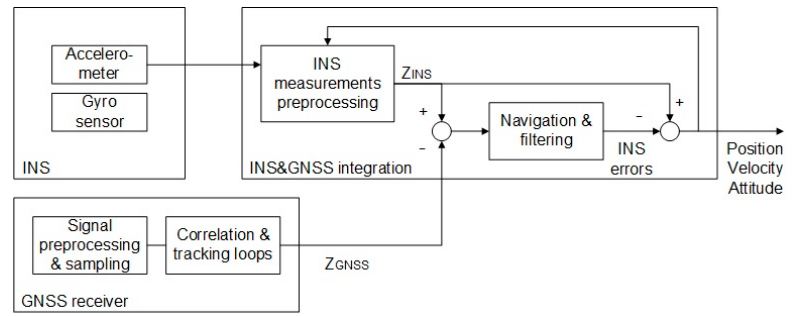
Figure 2. INS/GNSS tightly coupled integration scheme.